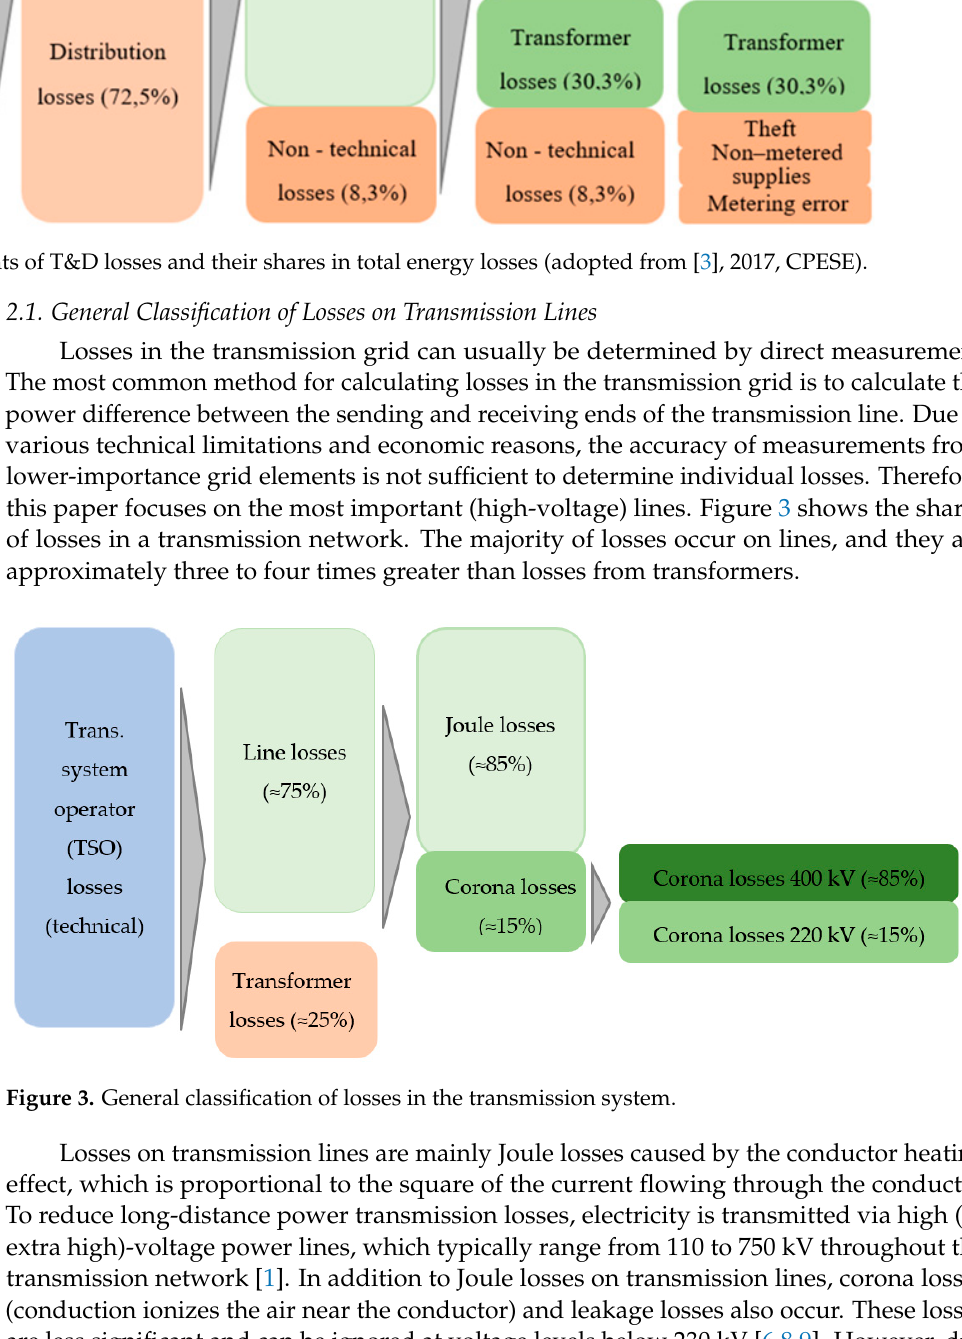
Figure 2. Components of T&D losses and their shares in total energy losses (adopted from [3], 2017, CPESE).